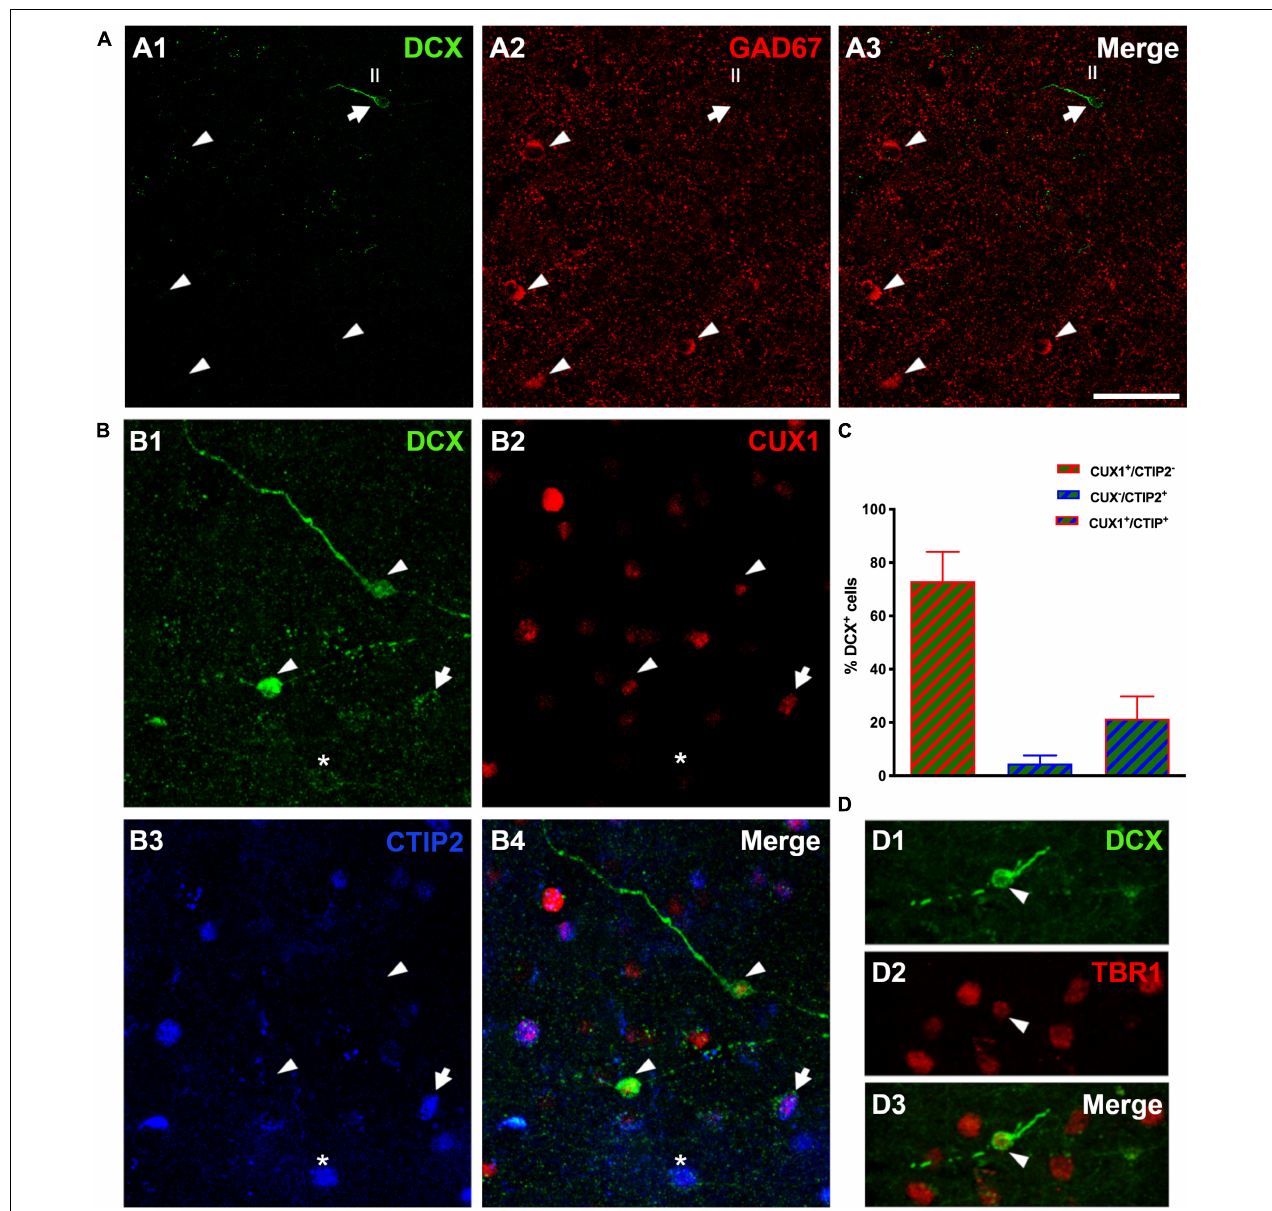
FIGURE 4 | Lineage of immature neurons in the human cerebral cortex layer II. (A) Panoramic view of 2D projections (10 consecutive confocal stacks, 1 µ m apart) showing the lack of co-localization between DCX (green) and GAD-67 positive cells (red). Note a single DCX large type I immunopositive cell (arrow) in the temporal cortex layer II, lacking GAD67 expression in its soma. GAD-67 immunoreactive cells (arrowheads) can be detected in the deeper layers of the cortex. (B) DCX + type II cells (green) co-expressing CUX1 (red, arrowheads), CTIP2 (blue, asterisk) or both transcription factors (arrow). (C) Graph showing the percentage of DCX cells expressing each transcription factor. Error bars represent the mean with ± SEM. (D) Immunofluorescence staining for DCX (green) and transcription factor TBR1 (red); arrowhead points to a type II cell co-expressing both markers. Images are 2D projections of 10 (A,B) and 15 (D) consecutive confocal stacks (1 µ m apart). Scale bar: 50 µ m for (A) , 25 µ m for (B) ; 10 µ m for (D) . All confocal images in this figure were from neurosurgical